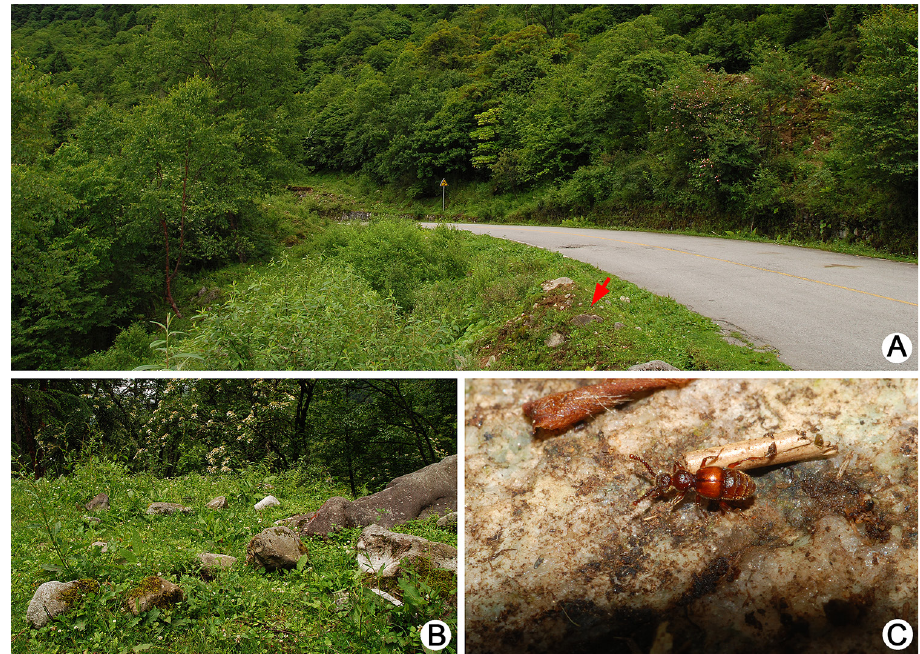
Figure 14. Habitat of Batrisodes xuhaoi . A General environment B A closer view of the habitat C A liv- ing Batrisodes xuhaoi walking on the underside of the